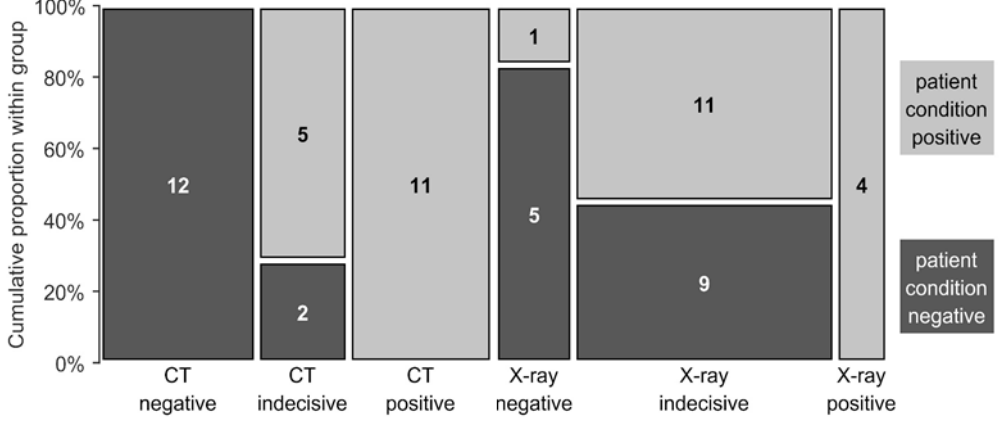
Fig. 4. Overall results of TFULDCT and